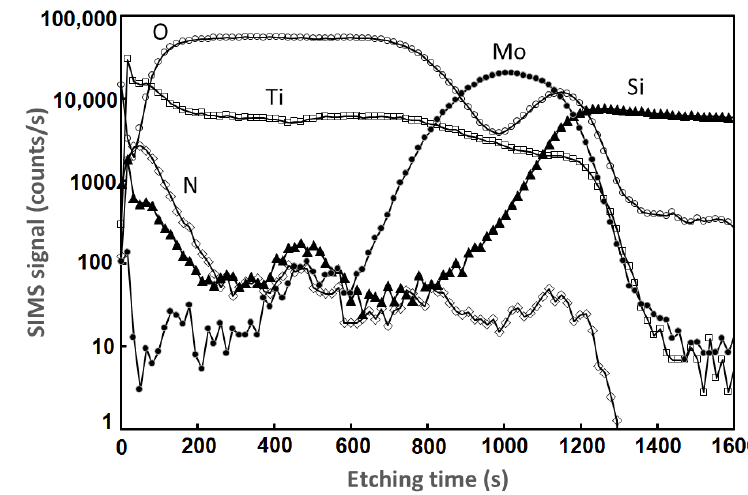
Figure 8. SIMS depth profiles of Mo–Ti bilayer films heated at 800 °C and exposed to (Ar-31%N 2 - 6%H 2 ) plasma for 1 h.